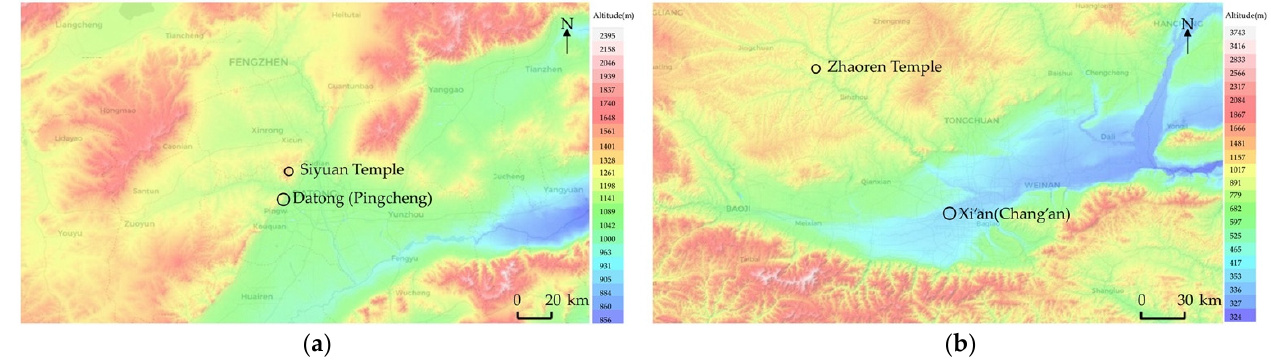
Figure 1. Elevation comparison. ( a ) The altitude of Datong (Pingcheng) City and Siyuan Temple; ( b ) the altitude of Xi’an (Chang’an) City and Zhaoren Temple.